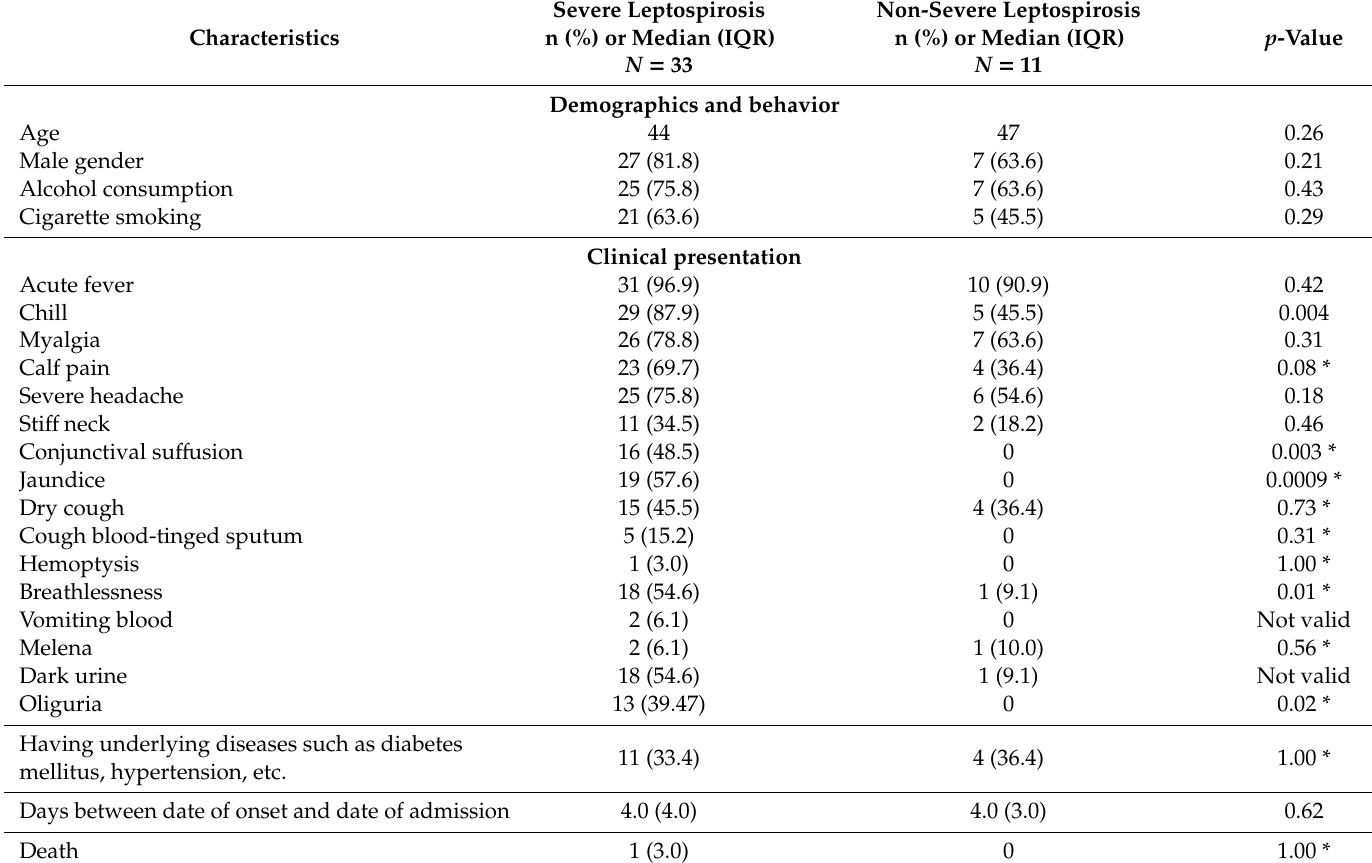
Table 1. Demographic and clinical characteristics of confirmed leptospirosis from 12 hospital-based sites in Thailand, 2017.